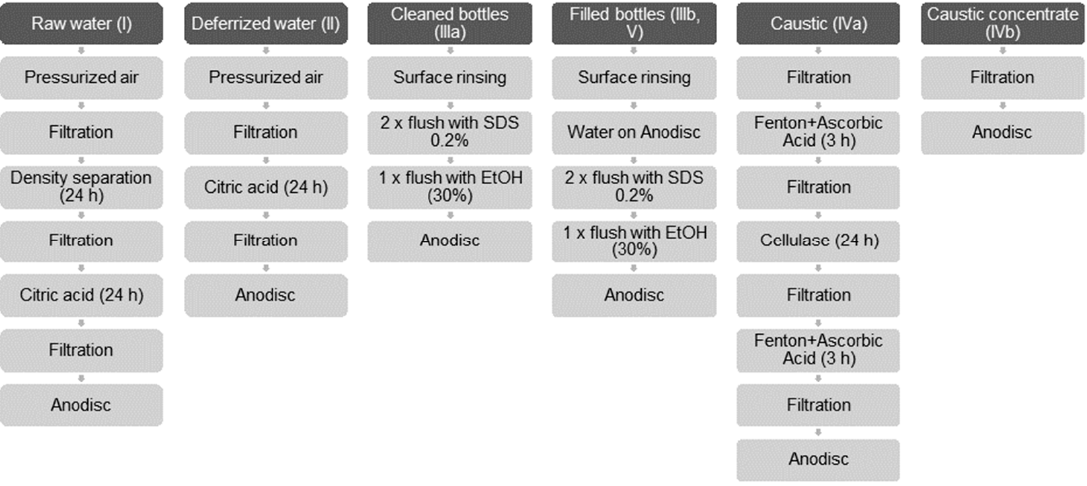
Figure 2. Sample preparation steps for sample types I–V.